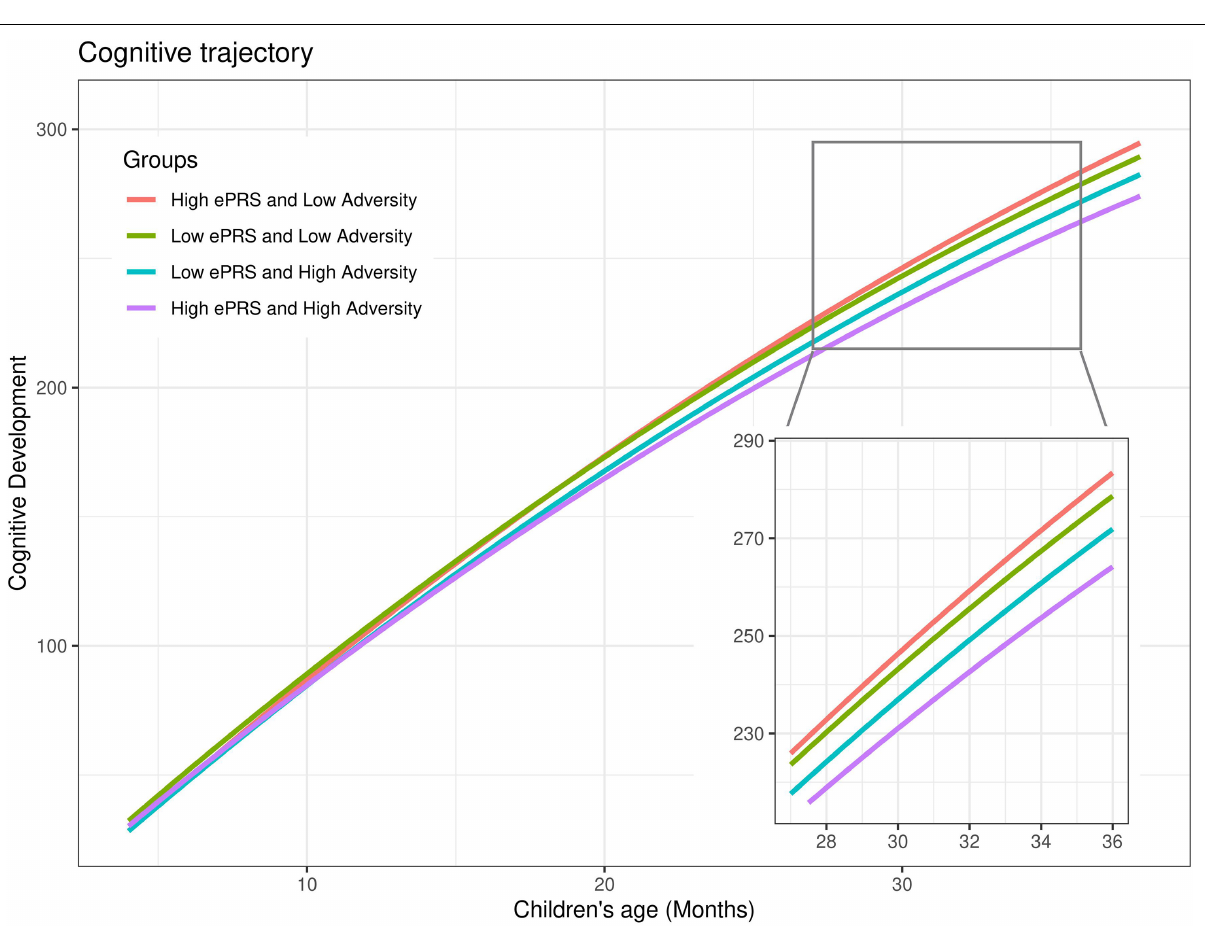
higher prenatal adversity was associated with slower cognitive development